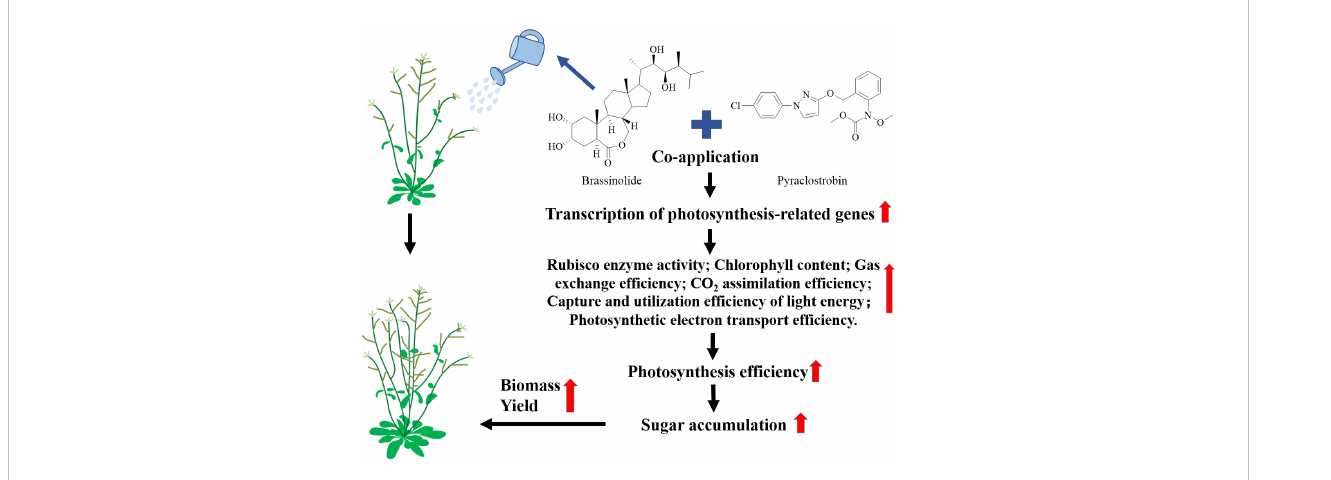
FIGURE 10 A potential model for the combined application of BL+Pyr in synergistically increasing biomass and yield through improving photosynthetic ef fi